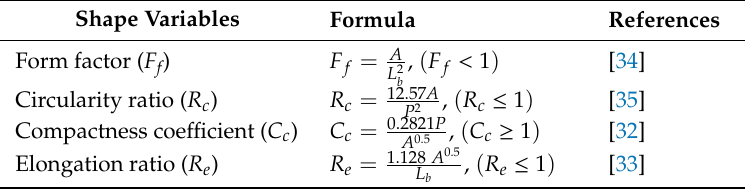
Table 3. Shape morphometric variables computation formulae with